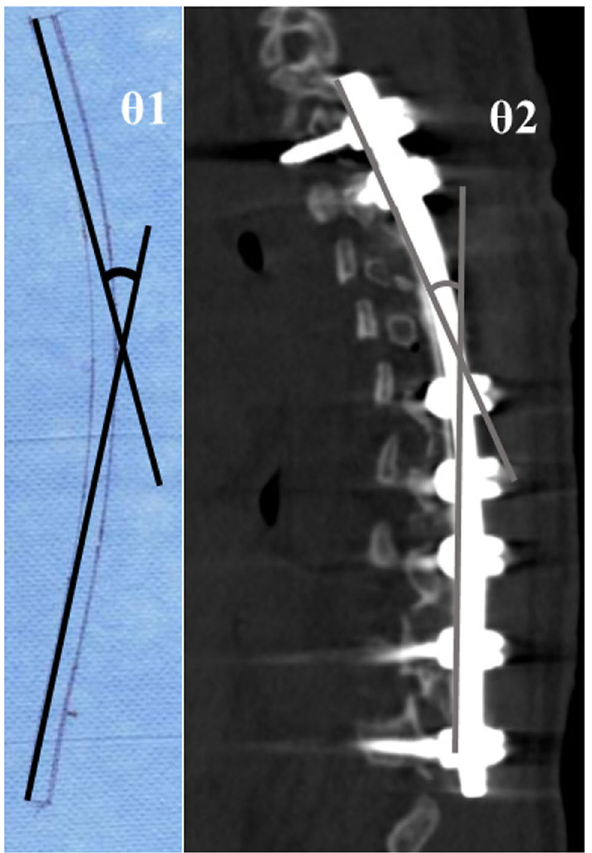
Figure 2. Rod angle before and after implantation. The angle between the proximal and distal tangential lines was measured. In case of notched rod, the surgeon traced the rod shapes on paper before implantation (θ1). The postoperative implant rod geometry (θ2) was obtained after the surgical operation using computed